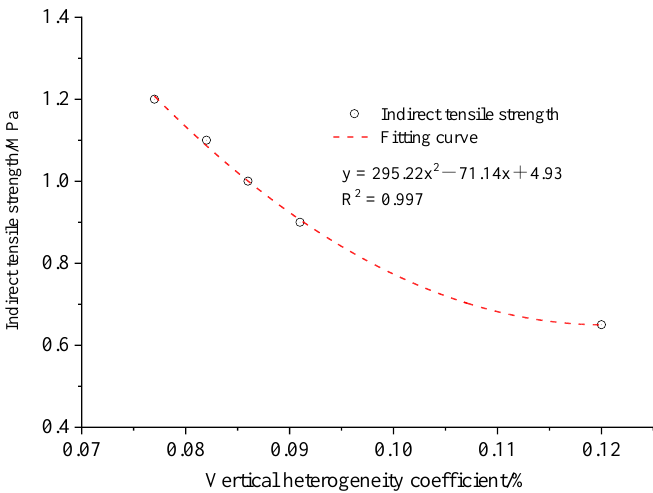
Figure 15. Relationship between vertical heterogeneity coefficient and indirect tensile strength.